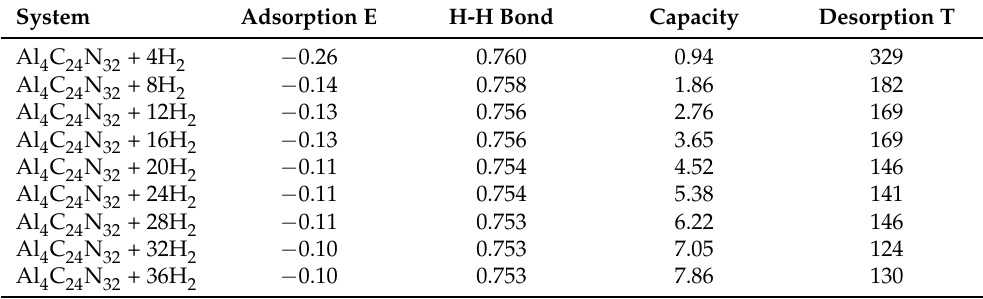
Table 1. The adsorption energy (E Ads , in eV) per H bonding length (in Å), the capacity of storage (wt%), and the desorption temperature ( T D , in K).